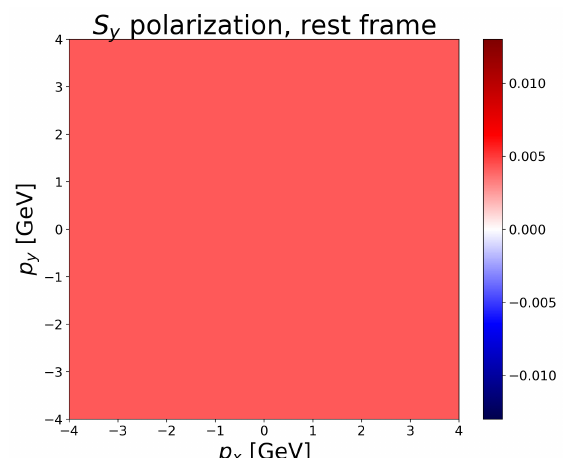
Figure 2. The only non-vanishing component of the polarization vector in the rest frame of the baryon is S y in the investigated simple solution; in this case, its value is uniquely determined by the magnitude of the Ω vector. More involved types of analytic solutions would yield some dependence on the momentum components, p x and p y . For the plotted value of S y (a constant, as seen in the plot), the same input parameters were used as above: m Λ = 1115 MeV/ c 2 , and | Ω | = 0.1 c /fm.